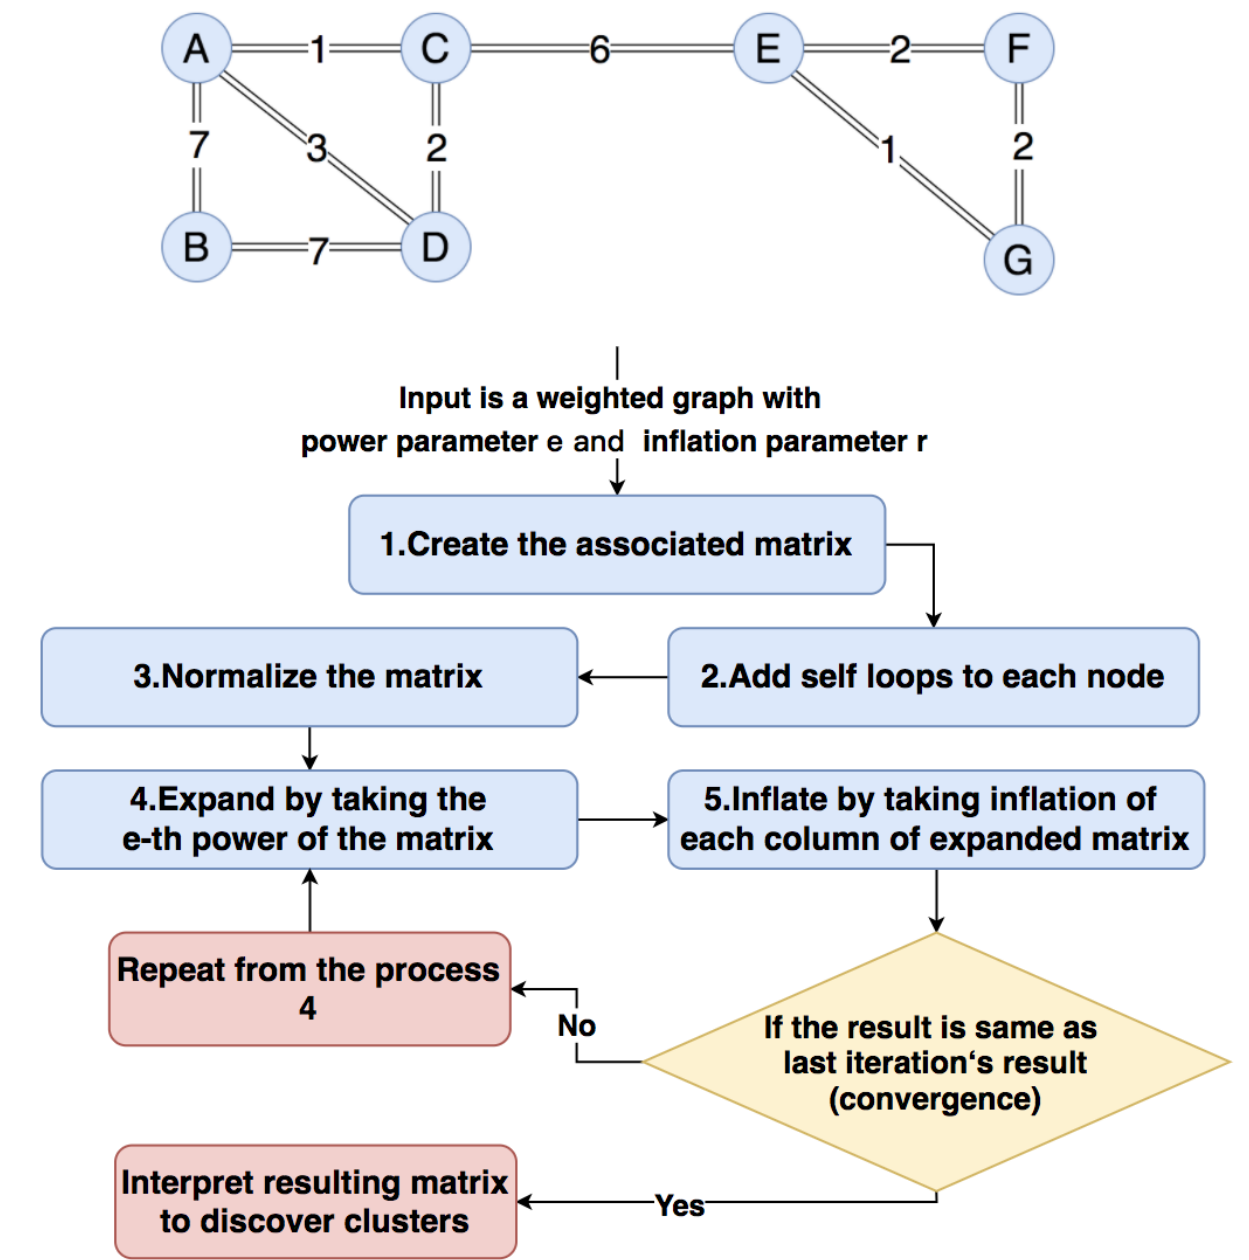
Figure 5. Markov cluster